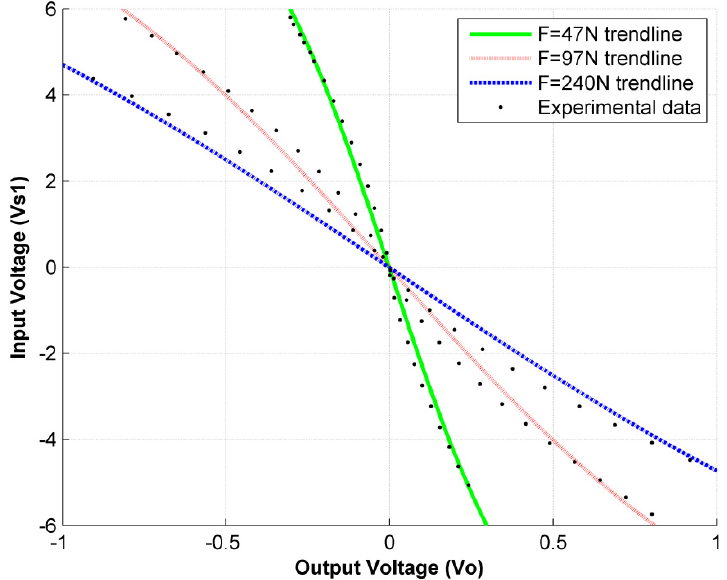
Figure 7. Graph representing the relation of V range ( − 6 V, 6 V) and forces of 47 N, 97 N and 240